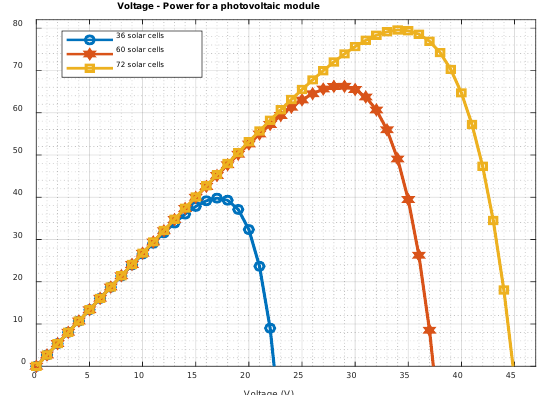
Figure 6. CB model of photovoltaic module to predict maximum power points as the number of solar cells changes.